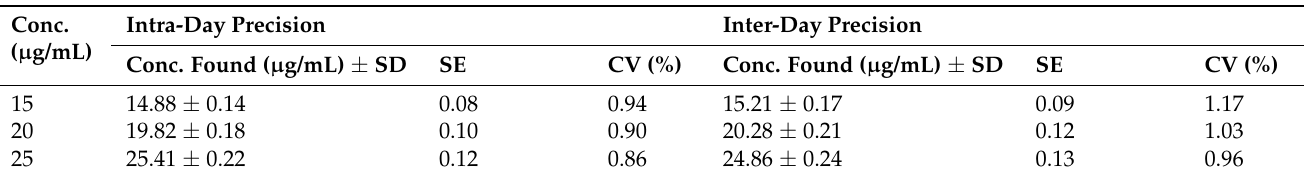
Table 5. Intra-day and inter-day precision data of CCM for the greener HPLC approach (mean ± SD; n =